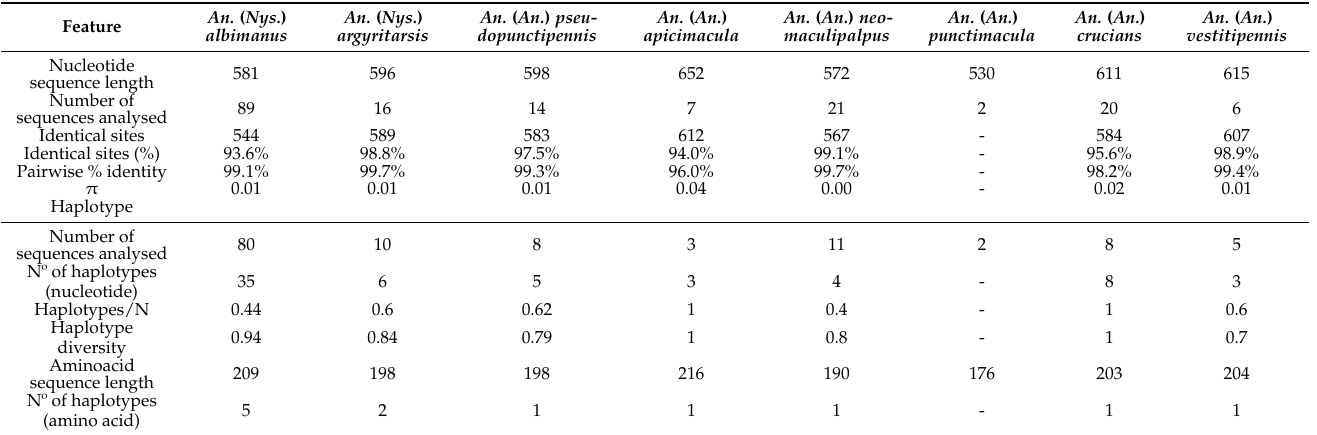
Table 3. Intraspecific comparison of nucleotide sequences, genetic diversity, and, number of haplo- types for COI in 8 species of Anopheles from Honduras.